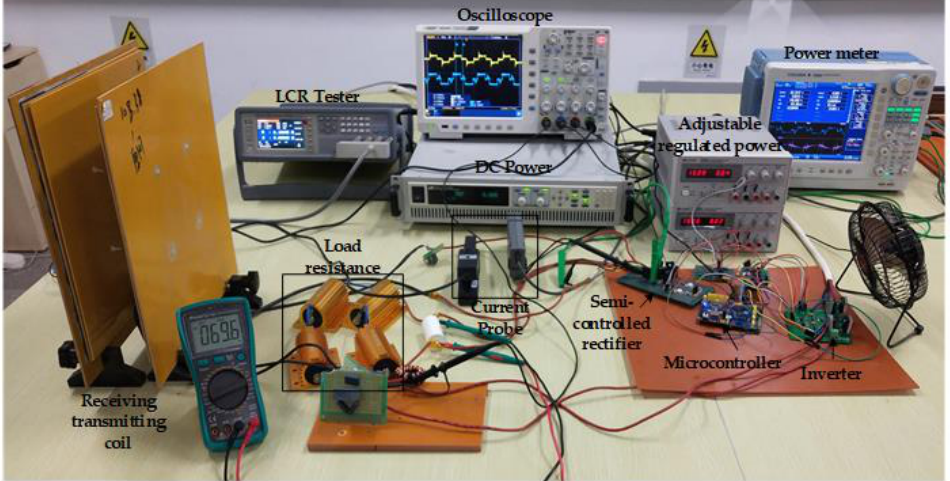
Figure 8. WPT system Experimental platform.